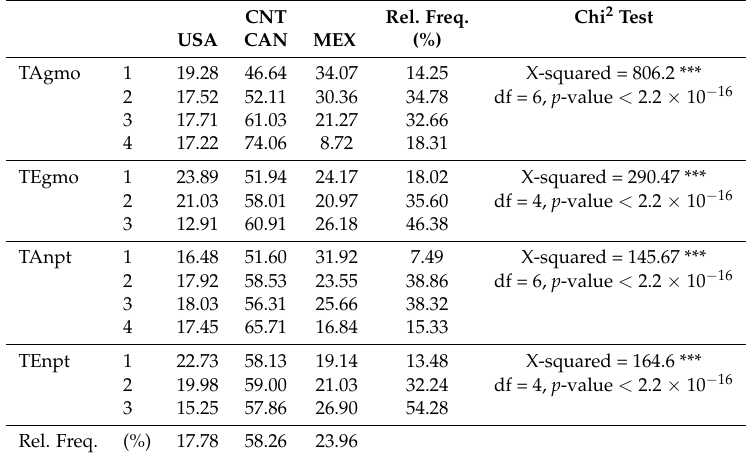
Table A2. Conditional and Relative Frequencies of Youth Technological Awareness and Expectation. CNT Rel.